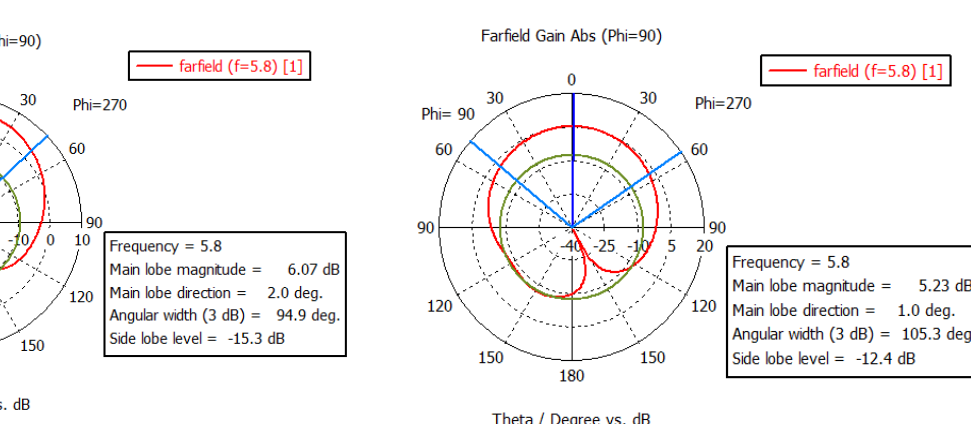
Figure 11. Far field in polar view for Arlon Di 522.